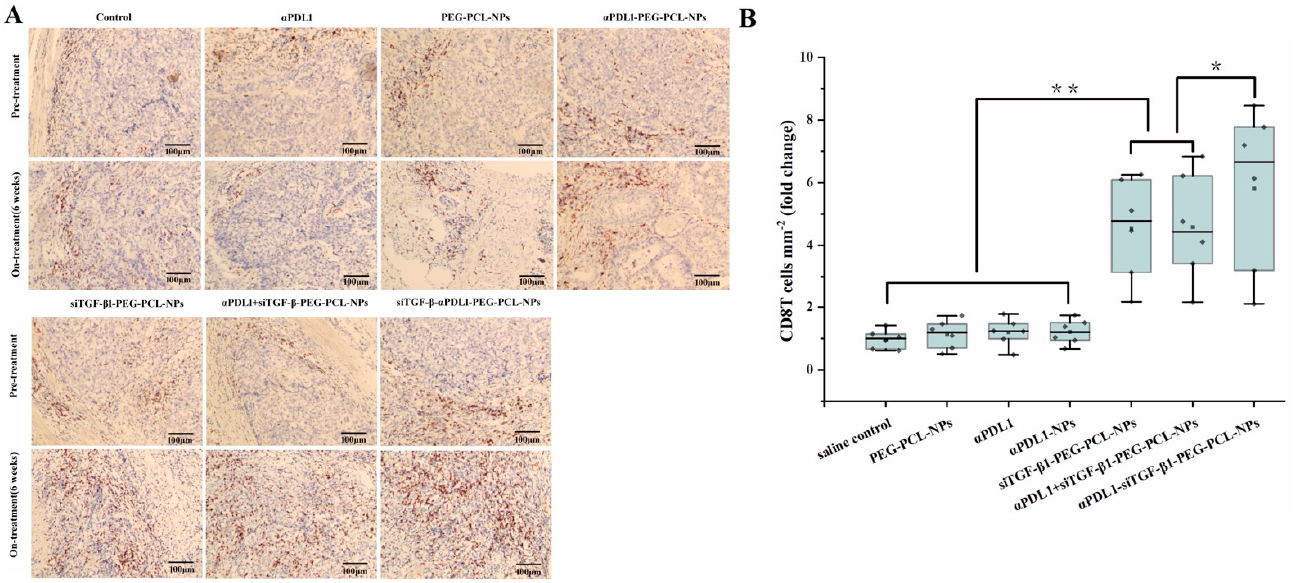
Figure 5. ( A ) Representative images of immunohistochemically stained CD8+ T cells in the center of TGF- β 1 + MFC 615 mouse tumors before and after different treatments (from up to down, saline control, PEG-PCL-NPs (NPs), α PDL1, α PDL1-NPs, siTGF- β 1-PEG-PCL-NPs α PDL1 + siTGF- β 1- PEG-PCL-NPs and α PDL1-siTGF- β 1-PEG-PCL-NPs). ( B ) Quantification of mean cell densities (cells/mm 2 ) for immunohistochemically stained CD8+ T cells. Images represent three independent experiments, N = 6 mice for all groups. (TGF- β 1, Transforming Growth Factor- β 1; * p < 0.05, ** p < 0.01).